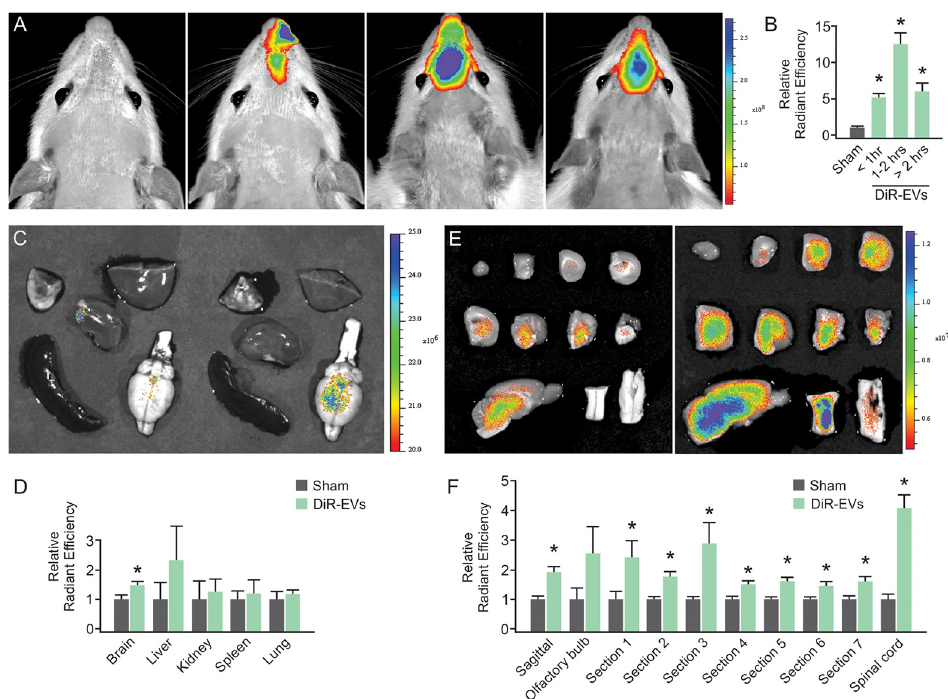
Fig 1. Biodistribution of IFN γ -DC-EVs after nasal delivery. (A) Representative low-power images of Xenolight DiR- labelled IFN γ -DC-EVs (DiR-EVs) fluorescence in the rostral portion of the nose/brain (Left-to-right: sham, < one hour post nasal administration of DiR-EVs, one-to-two hours post nasal administration, > two hours post nasal administration). Sham controls consisted of exosome-free (non-conditioned) media prepared in the same manner as conditioned media for labelling of EVs. (B) Quantification of radiant efficiency shows significantly ( � p = 0.040, < 0.001 and 0.025, respectively) higher fluorescence in the forebrain area of animals nasally administered DiR-EVs versus sham. (C) Imaging of organs (Top row: lung, kidney, liver; bottom row: spleen and brain) was performed for whole brain (therapeutic target) and liver, kidney, spleen (clearance/toxicity) and lung (for error in nasal delivery) at one hour post nasal administration. Representative images of Sham (Left) and DiR-EV (Right) organs are shown. (D) Quantification of radiant efficiency showed significantly ( � p = 0.018) increased signal in nasal administration DiR-EV whole brain, but not in other organs. To better visualize DiR-EV uptake, explanted brains were serially dissected into three mm sections. (E) Representative images of Sham (Left) and DiR-EV (Right) after nasal administration are shown, with coronal brain sections (1–8), a sagittal section to the lower left and two regions of upper (left) and mid (right) cervical spinal cord to the lower right. (F) Quantification of radiant efficiency showed significantly ( � p = 0.003–0.048) increased signal in all brain sections except olfactory bulb ( n = 5-7/group;